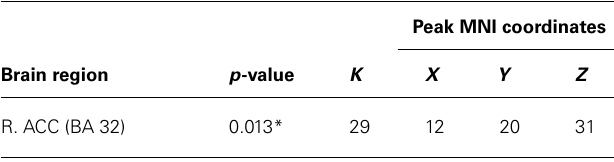
Table 3 |The effect of task difficulty in the IV > RV PPI-contrast for a ROI seed in the LIFG (BA 44,